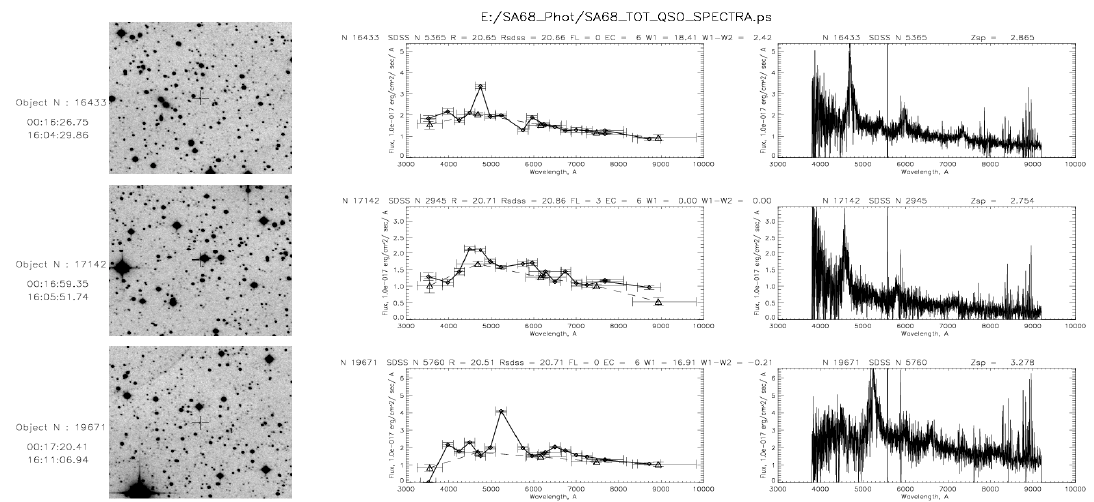
Figure 6. Some of medium-band selected AGN characteristics. The left images shows the object positions. The center images show medium-band SEDs (black dots with solid line) and broad-band SEDs (triangles with dashed line). The spectra of objects obtained with the 6-m telescope of SAO RAS are shown on the right.